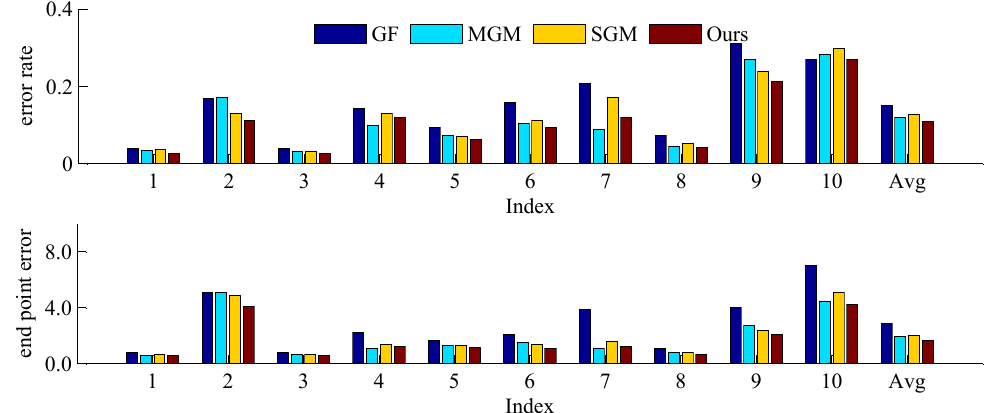
Figure 6. Comparison of GF, SGM, MGM and our method on Mibblebury 2014 dataset [36]. Images from top to bottom are the percentage of error pixel and average end-point error in non-occluded region for the 10 testing images.